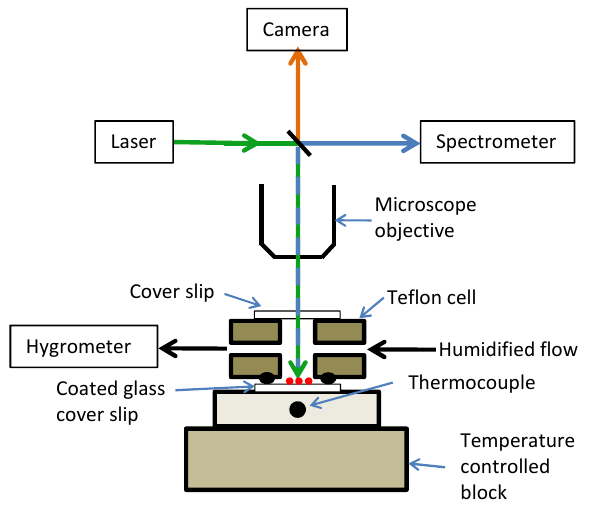
Fig. 1. Diagram of the humidity controlled stage coupled to a Ra- man microscope system used in this study. Not to